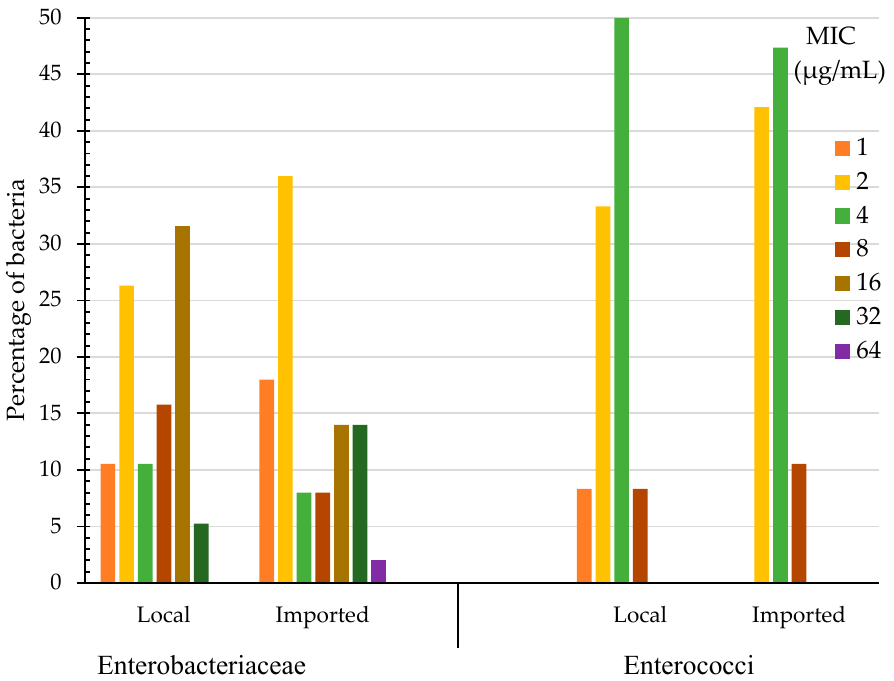
Figure 1. Chlorhexidine Minimum Inhibitory Concentration (MIC) of Enterobacteriaceae and enterococci (%) isolated from local and imported produce.